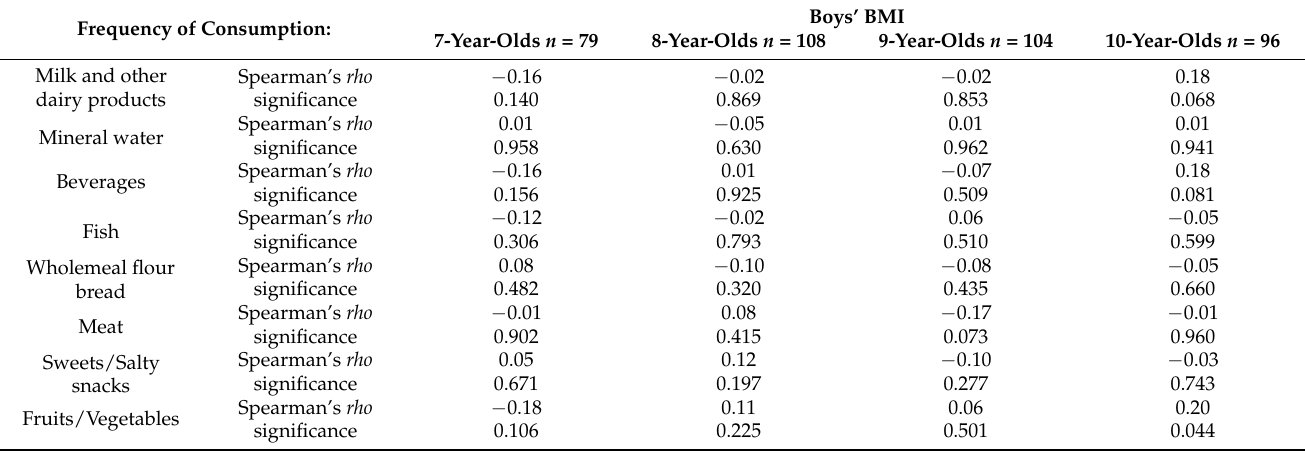
Table 5. The correlations between boys’ and girls’ BMI and consumption of milk, water, drinks, fish, wholemeal flour bread, meat, sweets/salty snacks and fruits/vegetables according to child’s